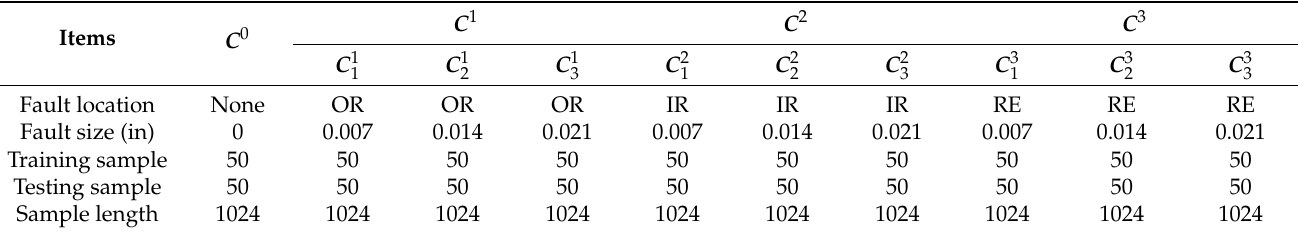
Table 2. Experimental data and parameter